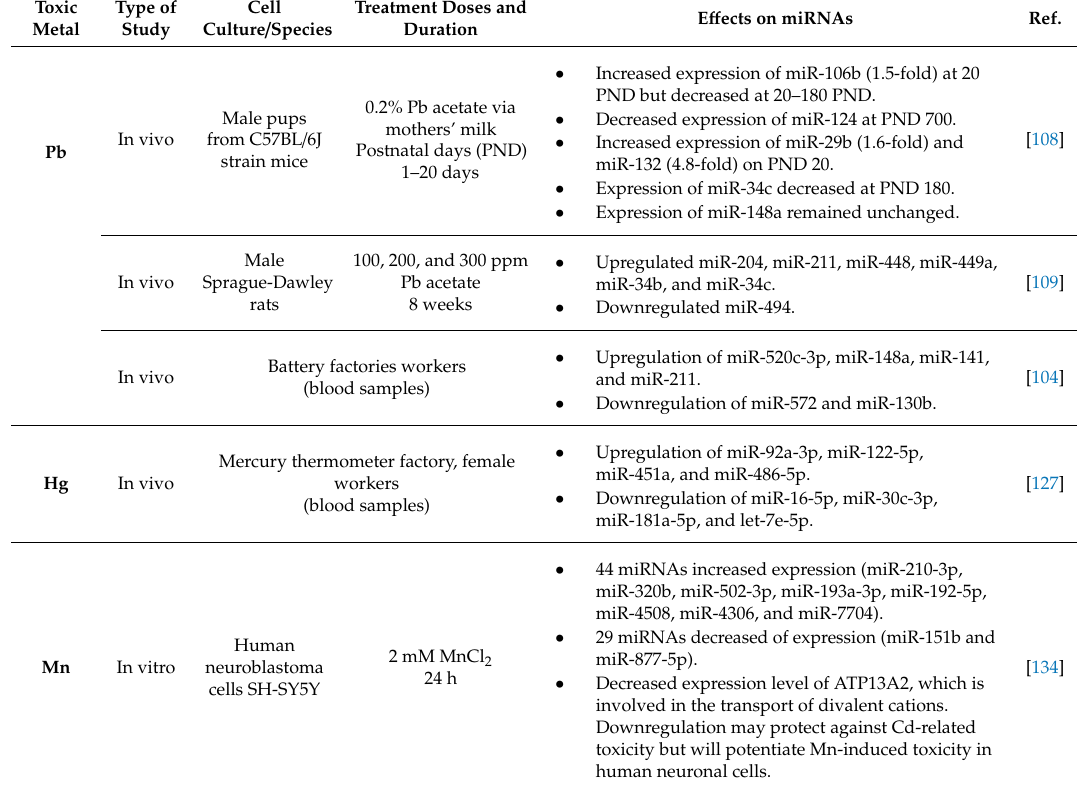
Table 3. Summary of studies analyzing e ff ects of Pb, Hg, and Mn on